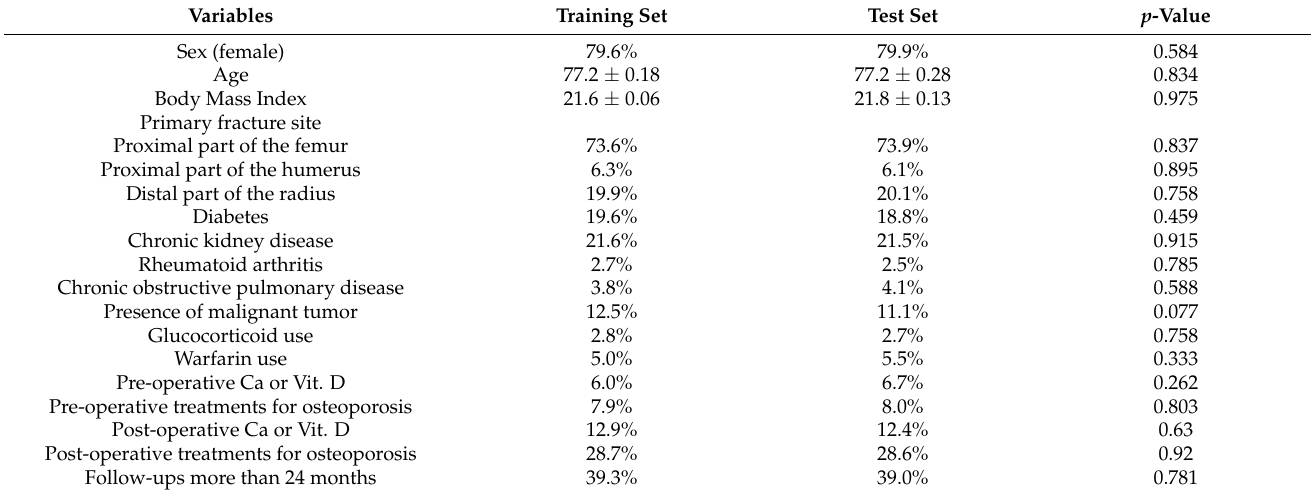
Table 2. Comparison of demographic data between the training and test sets.